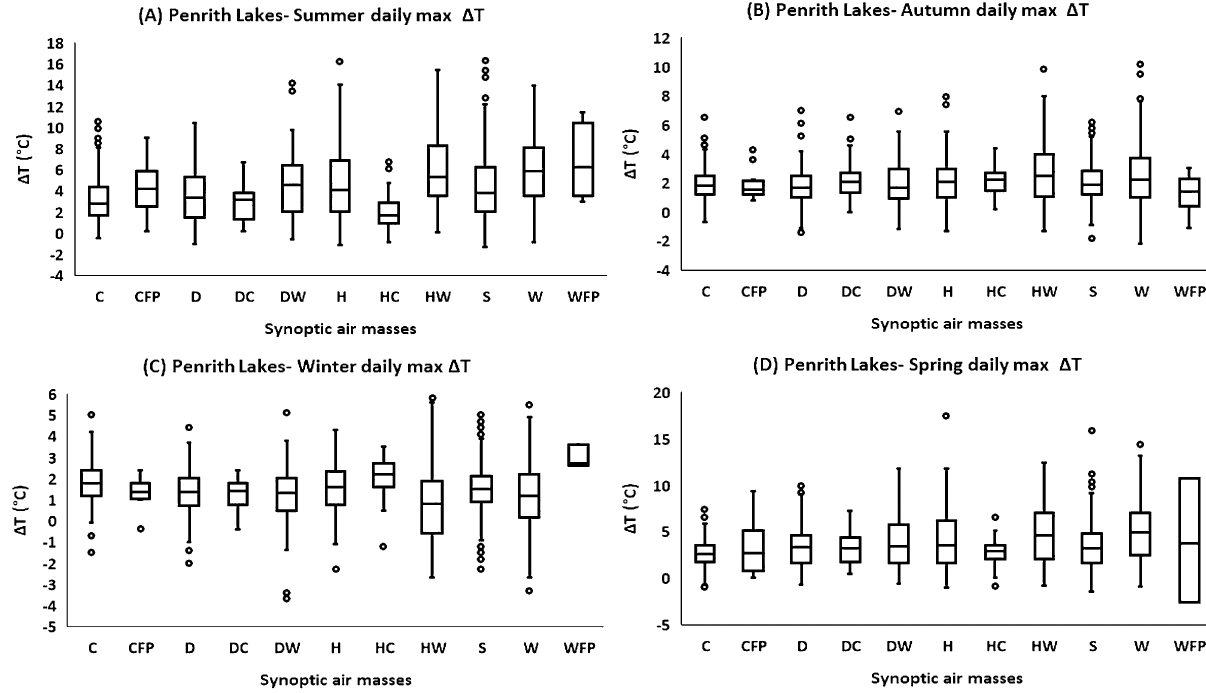
Figure 6. Synoptic air-masses and seasonal daily max ΔT comparison (1999–2017). ( A) Penrith Lakes during summer, ( B) Penrith Lakes during Autumn, ( C) Penrith Lakes during winter, ( D) Penrith Lakes during spring. The boxplots are plotted according to the general convention (upper and lower extremes: Q1-1.5*IQR and Q3 +